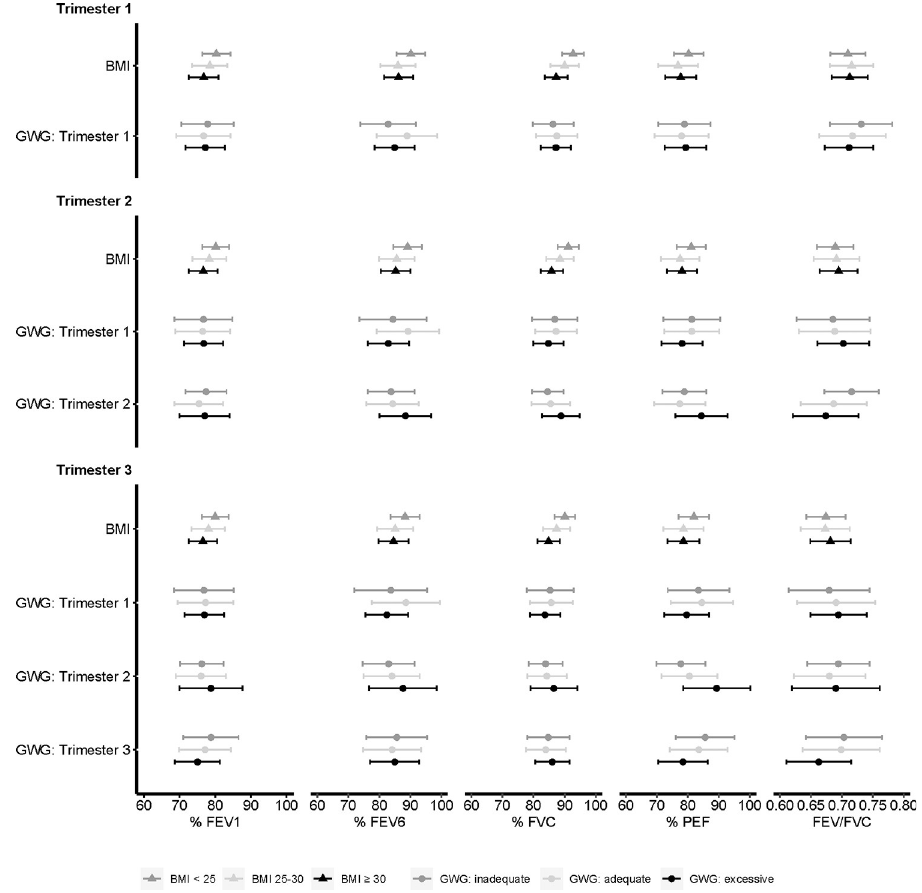
Abbreviations: % FEV1, percent predicted forced expiratory volume in 1 second; % FEV6, percent predicted forced expiratory volume in 6 seconds; % FVC, percent predicted forced vital capacity; % PEF, percent predicted peak flow; BMI, body mass index; FEV1/FVC, ratio of forced expiratory volume in 1 second to forced vital capacity; GWG, gestational weight